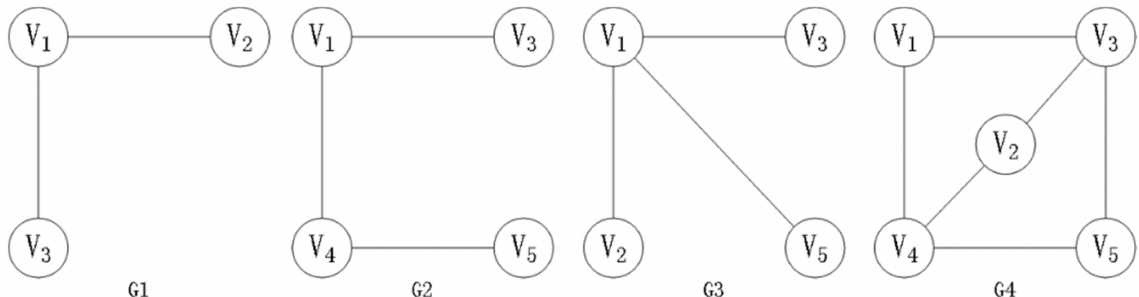
Figure 2. Example diagram of G 1 , G 2 , G 3 , G 4